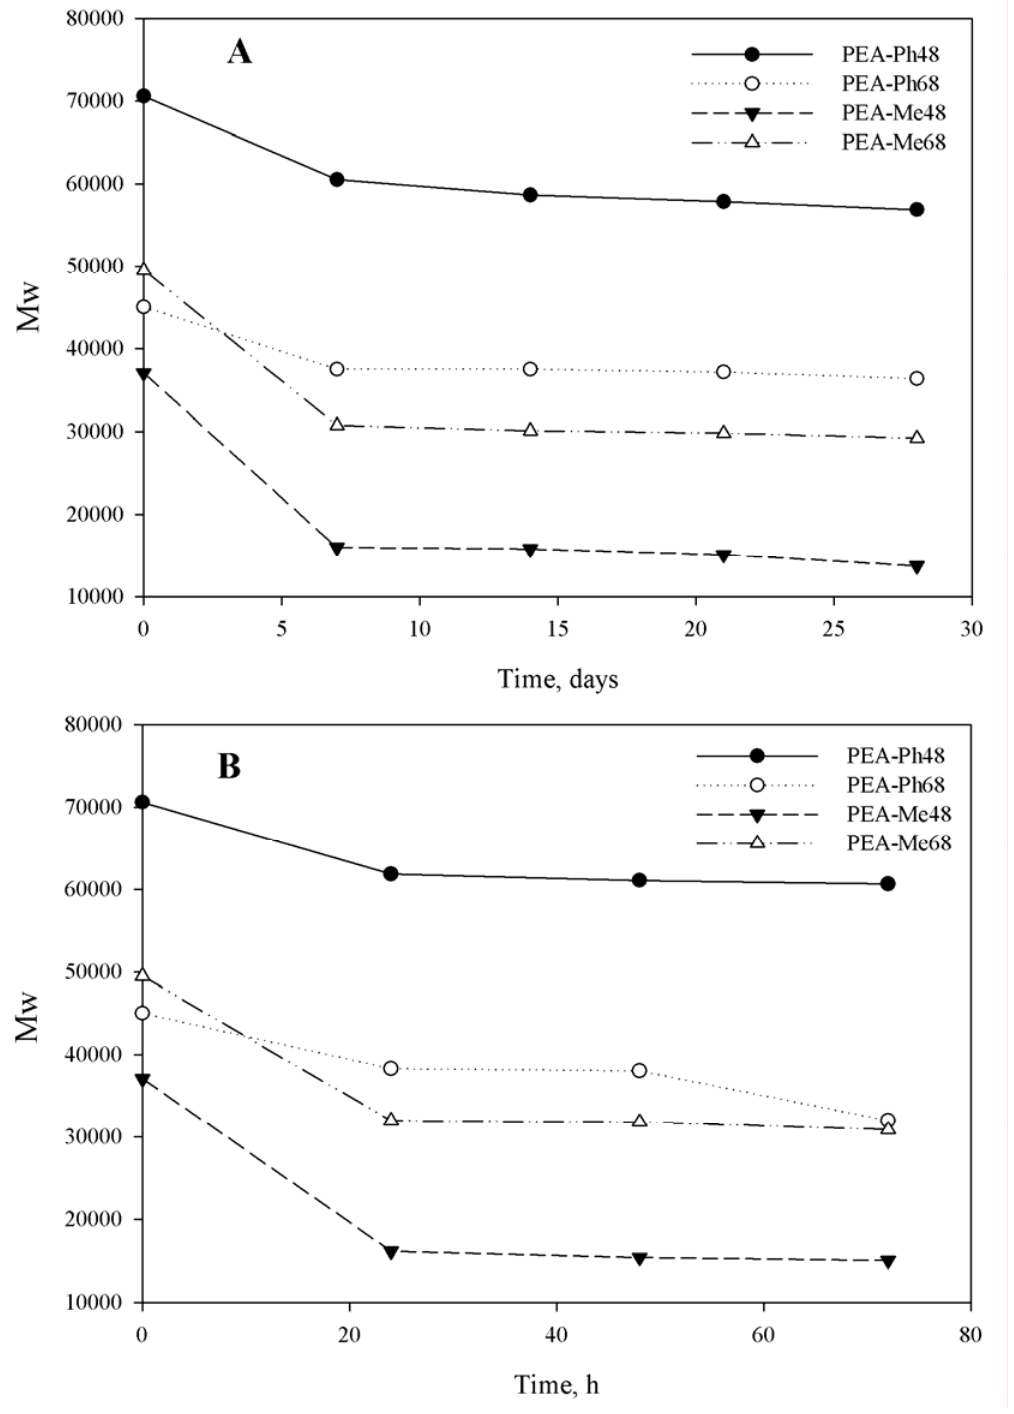
Figure 9. Molecular weight changes of PEAs incubated in (A) PBS at 37 °C for up to 28 days and, (B) chymprtypsin at 37 °C for up to 72